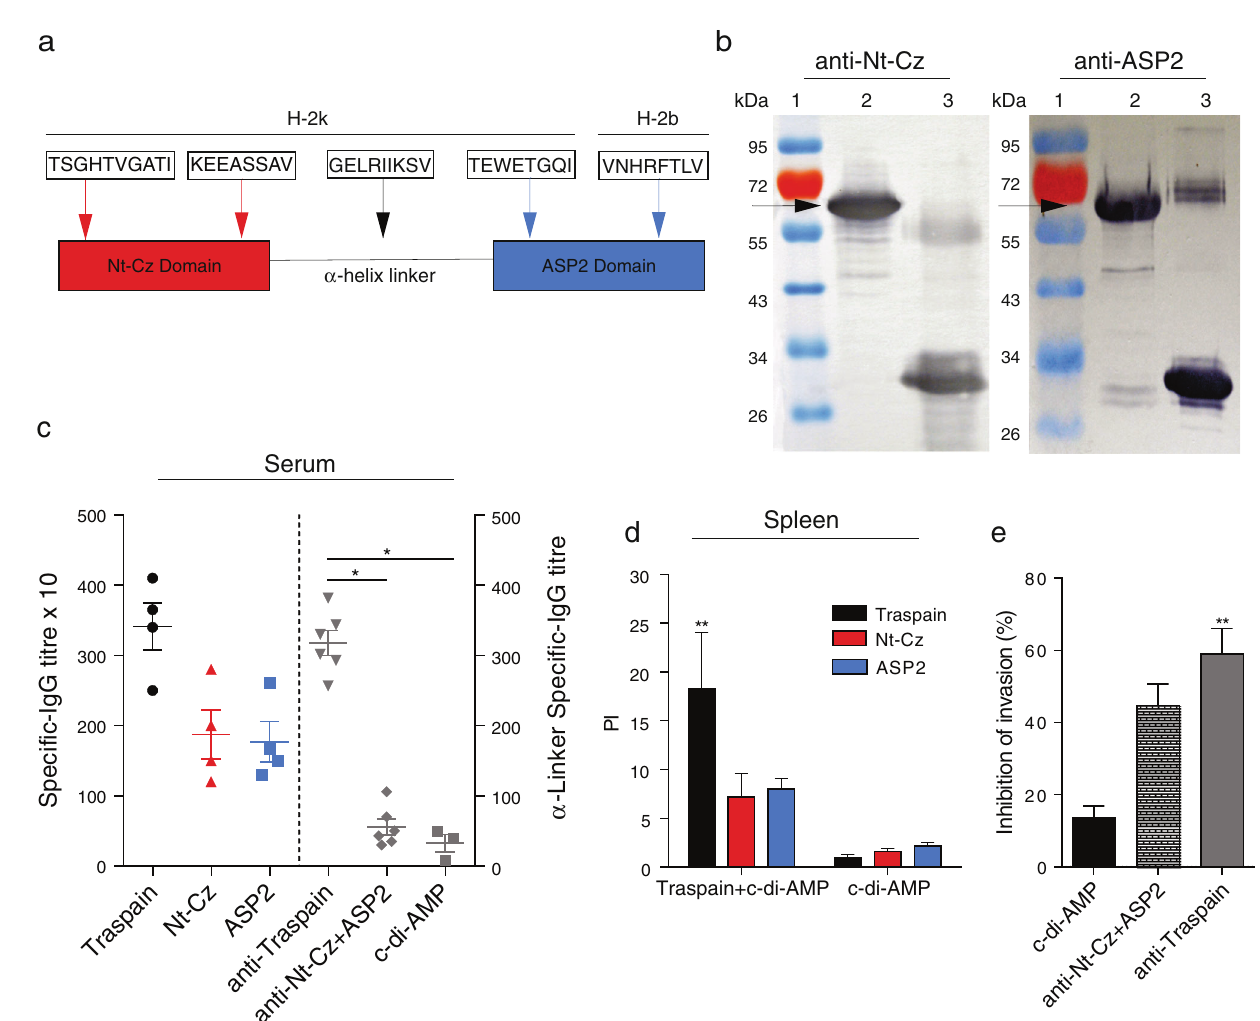
Fig. 1 Characterization of Traspain as a chimeric immunogen. Schematic representation of Traspain. Arrows point at CD8 + T cell epitopes included in the design with its respective mouse MHC-I haplotype ( a ). Immunochemical identity by Western blot. Domain-speci fi c polyclonal antibodies (pAb) were used as primary antibody. SDS-PAGE gels were loaded as follows, lines: 1-MWM, 2-Traspain, 3-Nt-Cz ( left ) or ASP2 ( right ), arrows point at Traspain band ( b ). Speci fi c antibodies response. Titers were determined by ELISA in serum samples from mice vaccinated with either Traspain or antigen combination plus c-di-AMP at 15 days post vaccination. Plates were coated with Traspain, Nt-Cz, ASP2 ( left ) or GELRIIKSV α -linker-peptide ( right ). * p < 0.05, one-way ANOVA Kruskal-Wallis test + Dunn ’ s multiple comparisons test ( c ). Proliferative response in vaccinated mice 30 days after the last dose. Spleen cells were re-stimulated with 10 µg/ml of the indicated protein. Results are expressed as proliferation index (PI), n = 6 mice per group, ** p < 0.01, 2-way-ANOVA + Tukey ’ s multiple comparisons test ( d ). Neutralization assay of pAb generated upon vaccination. n = 5 – 6 per group, ** p < 0.01, one-way-ANOVA Kruskal-Wallis test + Dunn ’ s multiple comparisons test ( e ). Results are expressed as mean ± SEM and are representative of at least three independent